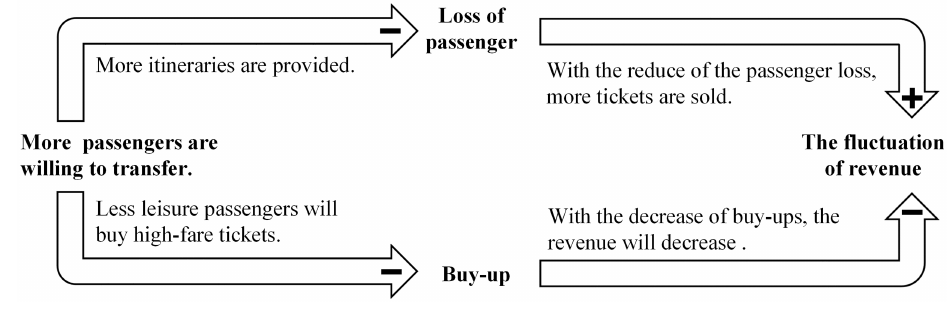
Fig 11. The two-sided effect of transfers on revenue.